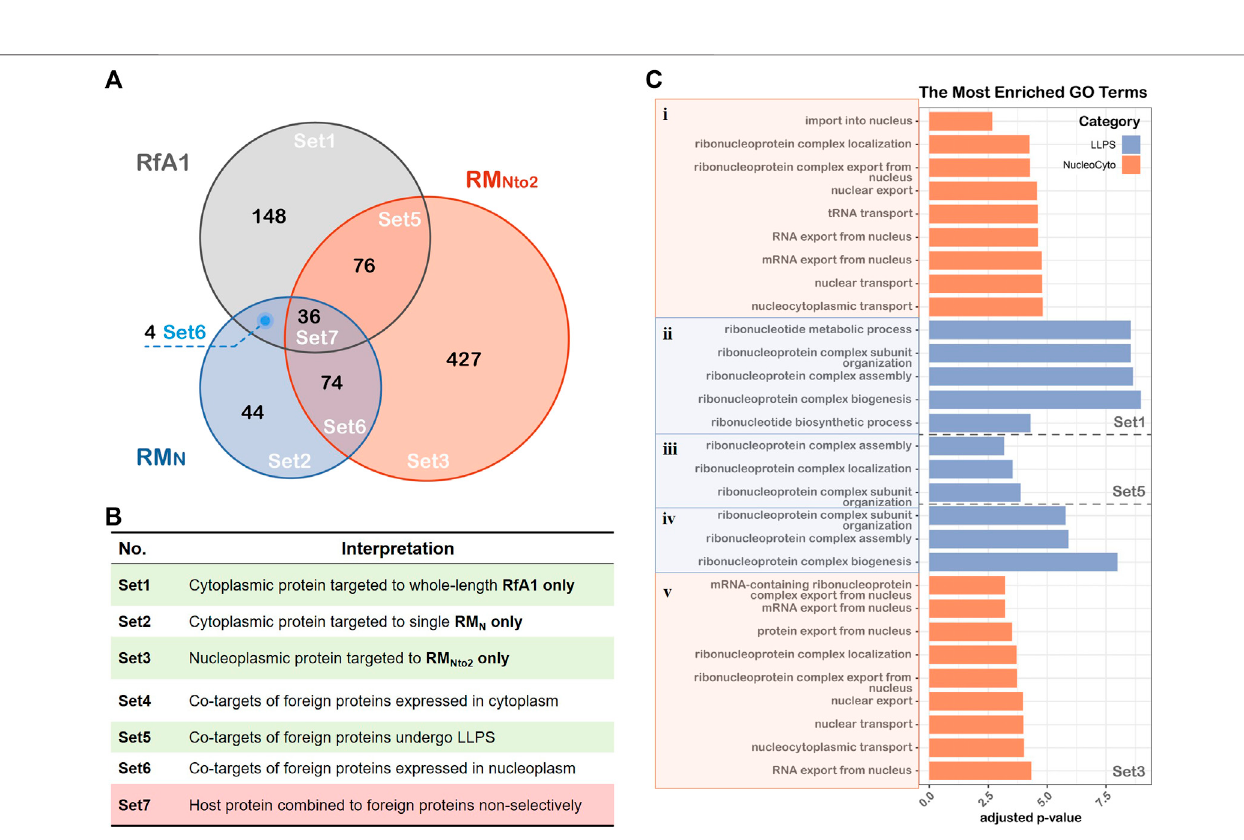
Frontiers in Cell and Developmental Biology |